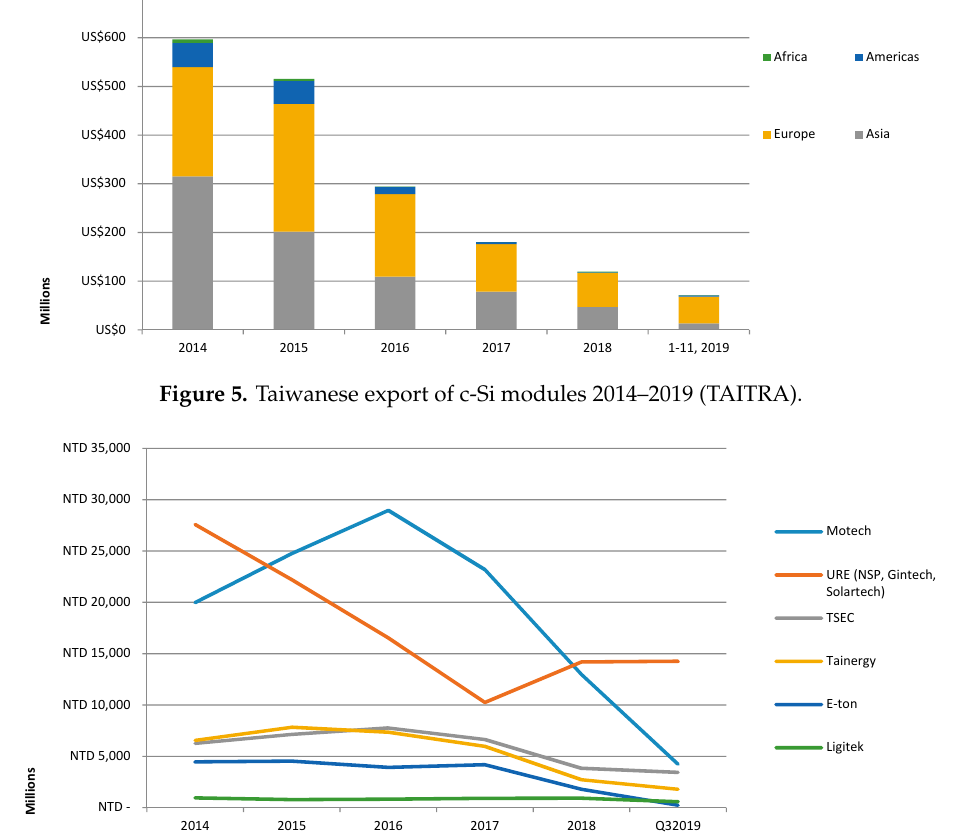
Figure 6. The revenue decrease of selected stock listed Taiwanese PV entities (Sourced: Digitmes, based on Taiwan Stock Exchange